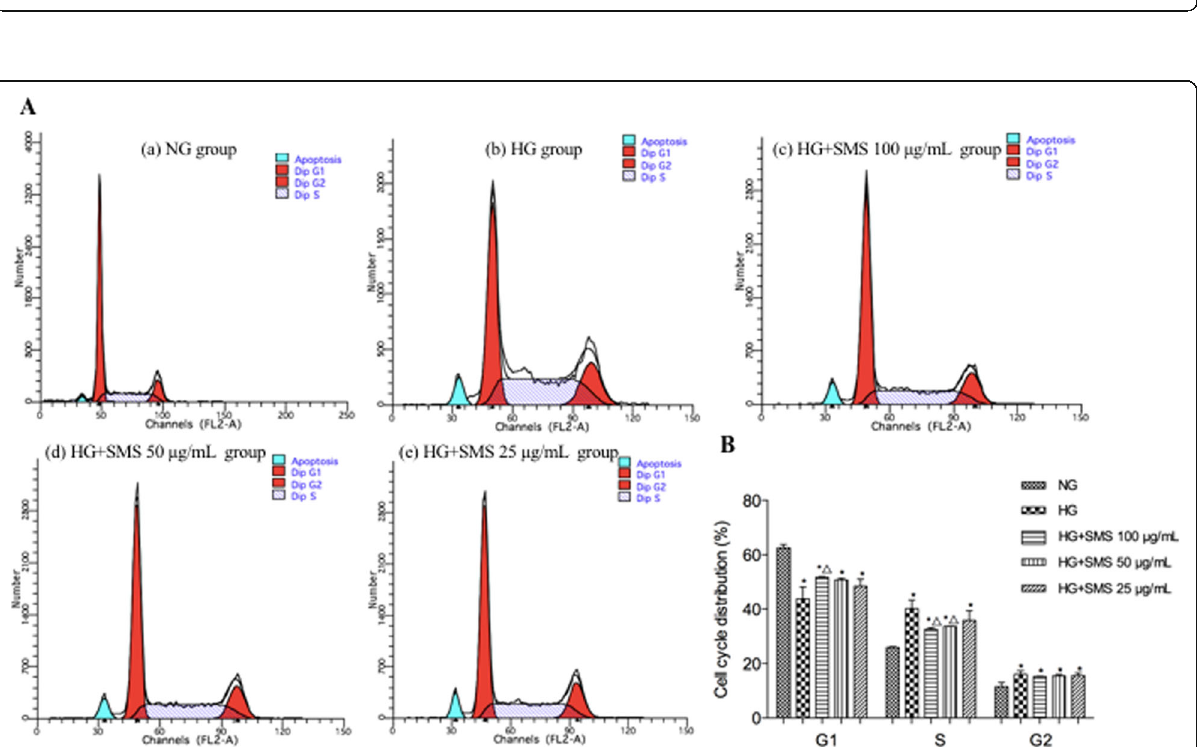
Fig. 3 Effect of SMS on the H9C2 cell apoptosis exposed to HG. a The percentage of apoptotic cells in each group. b Cells were detected with a flow cytometer